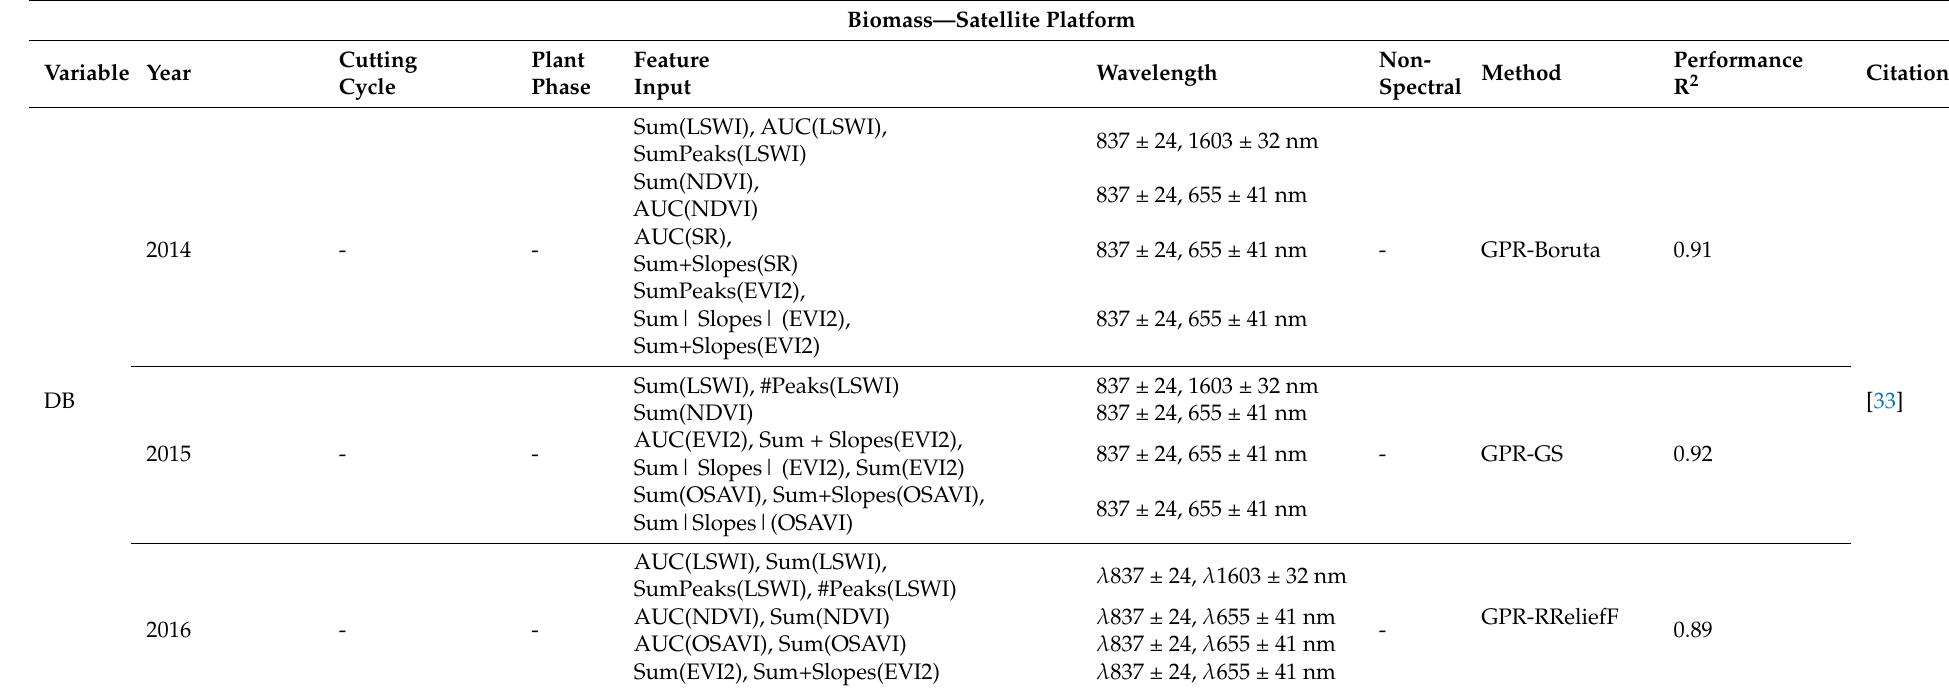
Table A3. Most accurate features for predicting alfalfa biomass using satellite platforms. Biomass—Satellite